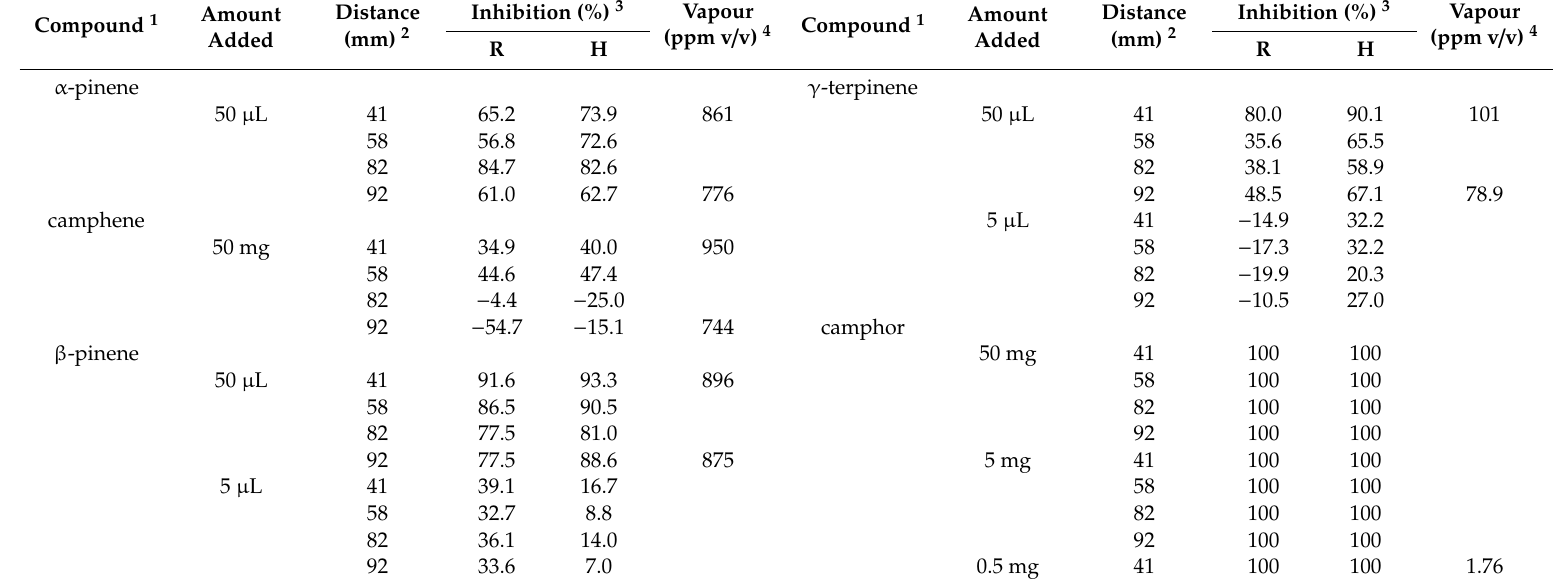
Table 3. Plant growth inhibitory activities and vapour phase concentrations of authentic